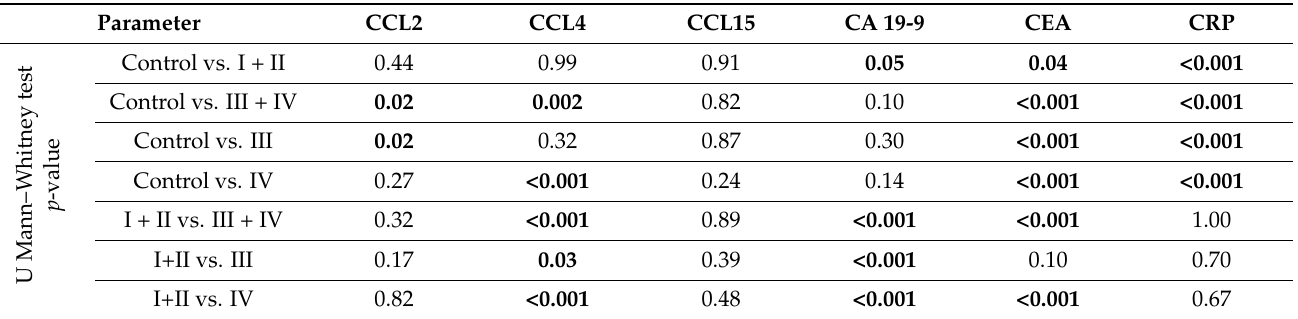
Table 4. U Mann–Whitney test analysis results between control group and TNM